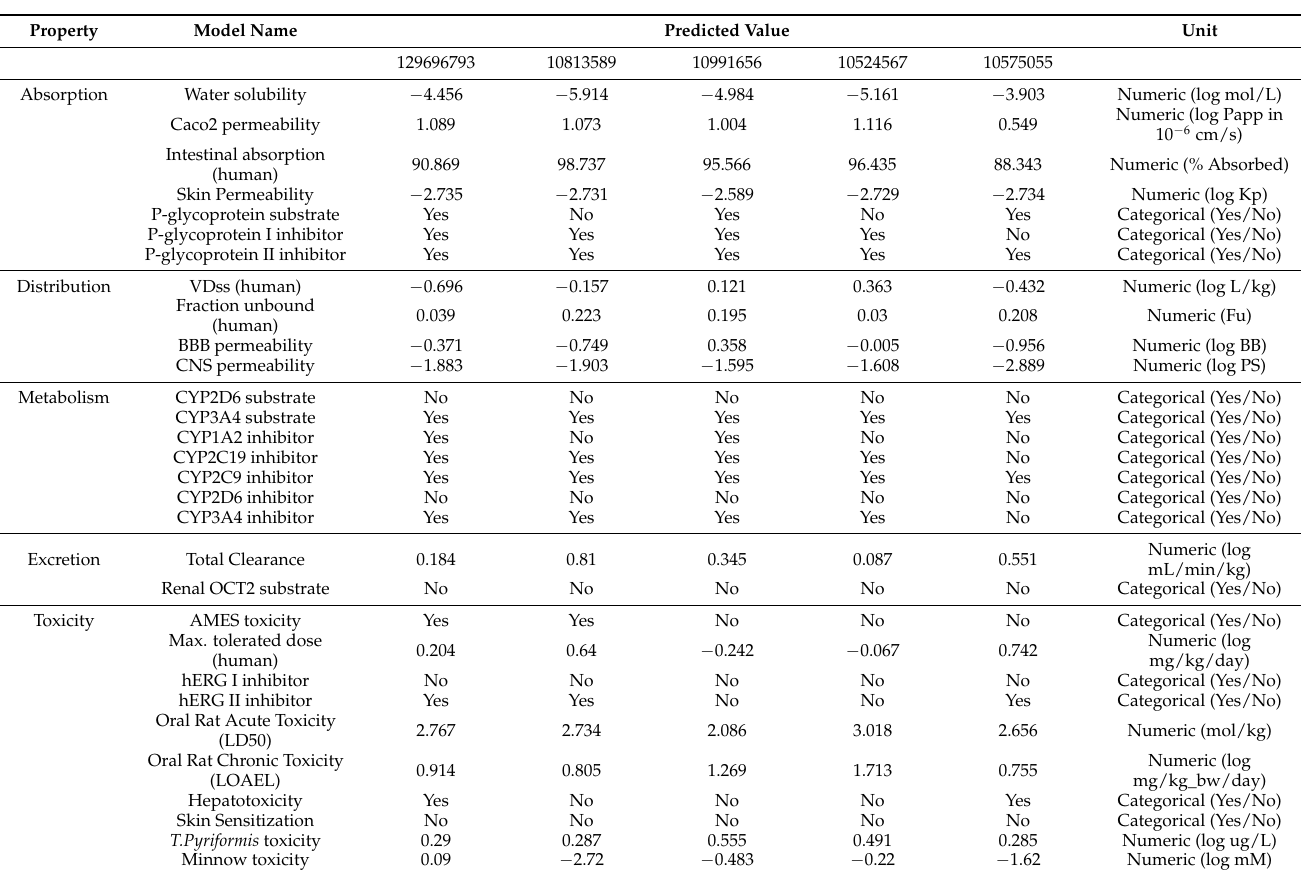
Table 8. ADMET properties of the selected flavonoids against